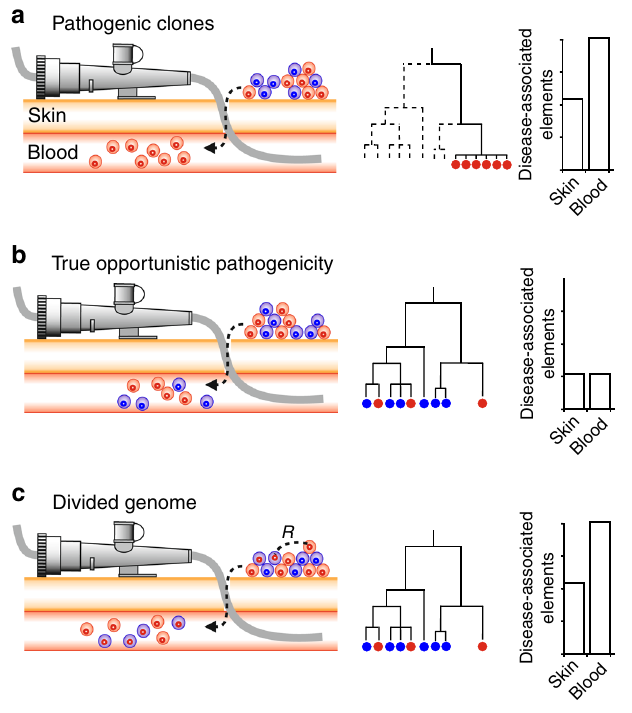
Fig. 5 Contrasting models of S. epidermidis infection and associated variation in conceptual genomic data. Each panel summarises scenarios for subcutaneous colonization from the primary commensal skin environment to the blood (left), and the impact on an S. epidermidis population of two clones (blue and red circles) and their genomes (internal circles) which may be enriched for putative pathogenicity-associated genes (red) or not (blue). Genealogical reconstructions of isolates sampled from infected blood are shown in the middle column. The prevalence of disease determinants in the genome of isolates from skin and blood are shown on the right. a Proliferation of pathogenic clones: clones with genomes enriched for pathogenicity determinants proliferate in the blood and other strains do not, observed as a discrete pathogen lineage on the tree. b True opportunistic pathogenicity: multiple genetically divergent clones proliferate in the blood and disease determinants are equally distributed among the genomes of isolates from the skin and the blood (or would be undetectable). c Divided genomes: horizontal gene transfer (R) spreads pathogenicity determinants into multiple genomic backgrounds allowing divergent clones to colonize the blood